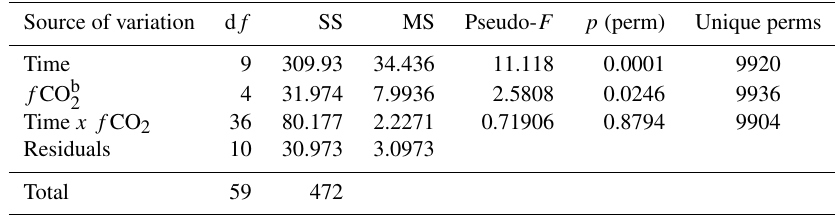
Table 1. Results of two-factor permutational multivariate analysis of variance (PERMANOVA) a on a resemblance matrix (Euclidian distance) of normalized chemical variables (Phosphate, DOC, TDN, DSi, TPC, PON, POP, BSi). Degrees of freedom (d f ); sum of squares (SS); mean square (MS).